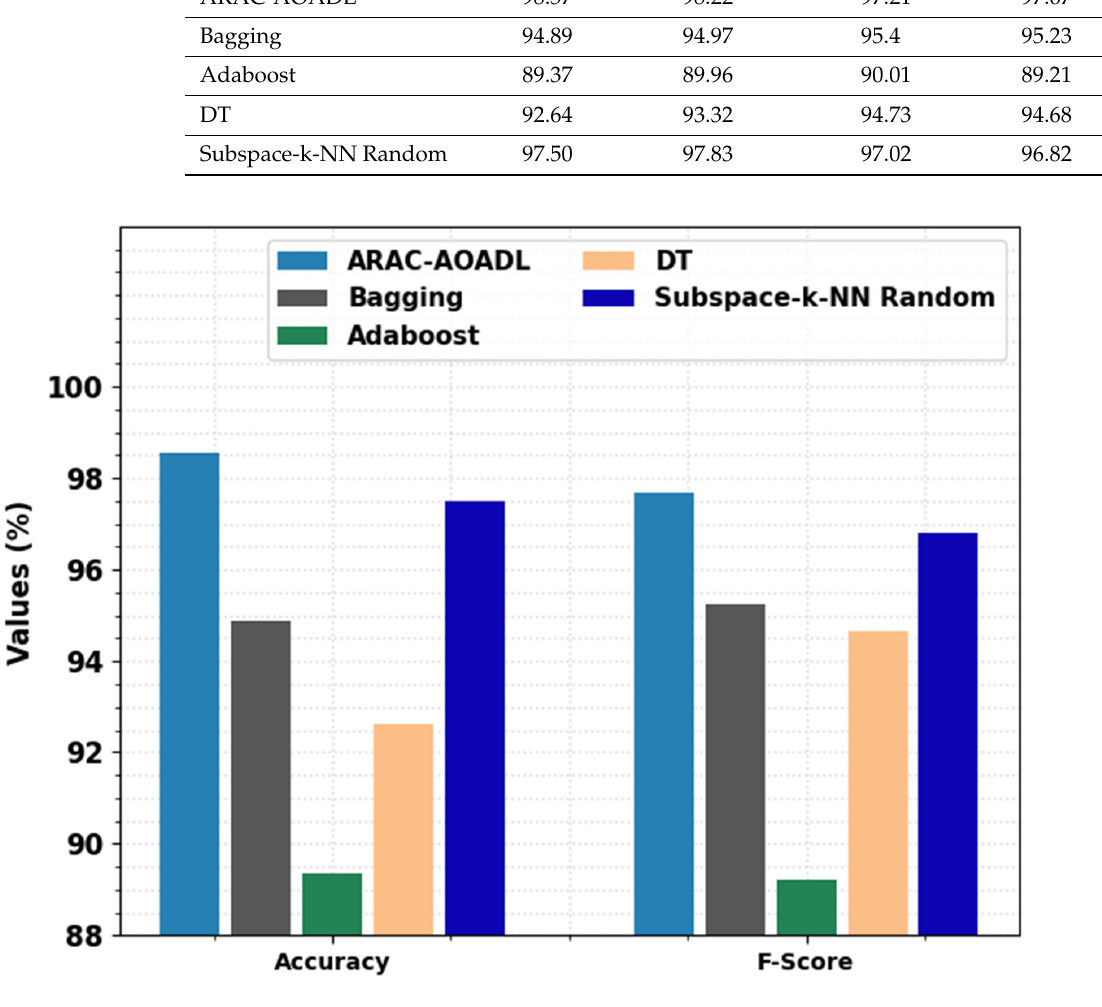
Figure 6. Comparative RA Classification results of ARAC ‐ AOADL model interms of 𝑎𝑐𝑐𝑢 (cid:3052) and 𝐹 (cid:3046)(cid:3030)(cid:3042)(cid:3045)(cid:3032)